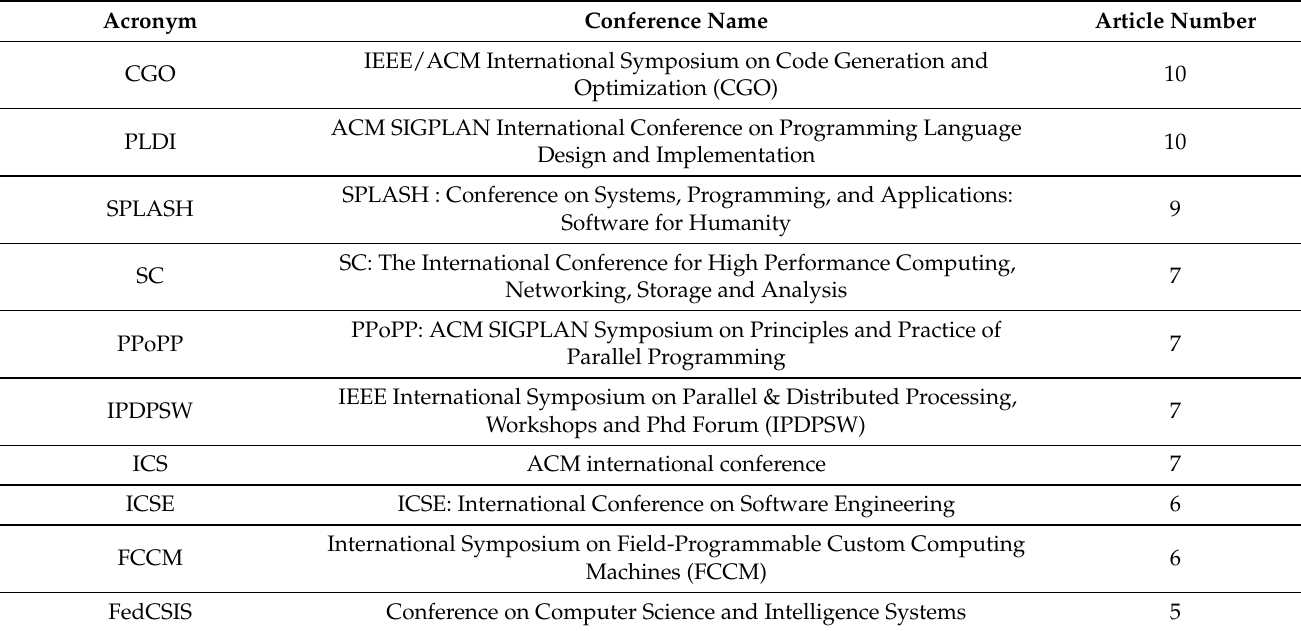
Table 9. Top 10 most-used conferences.